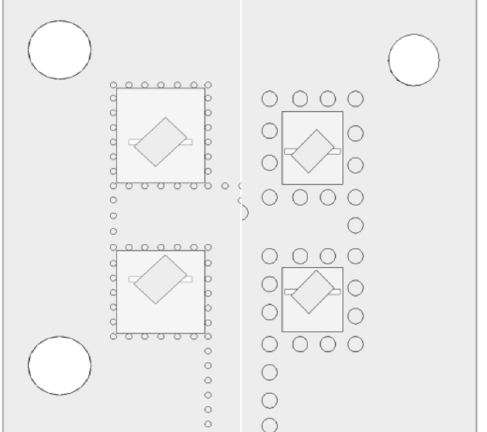
Figure 5. Comparison of arrays with smaller vias ( left ) and larger vias ( right ). Only half of the structures are shown due to symmetricity.